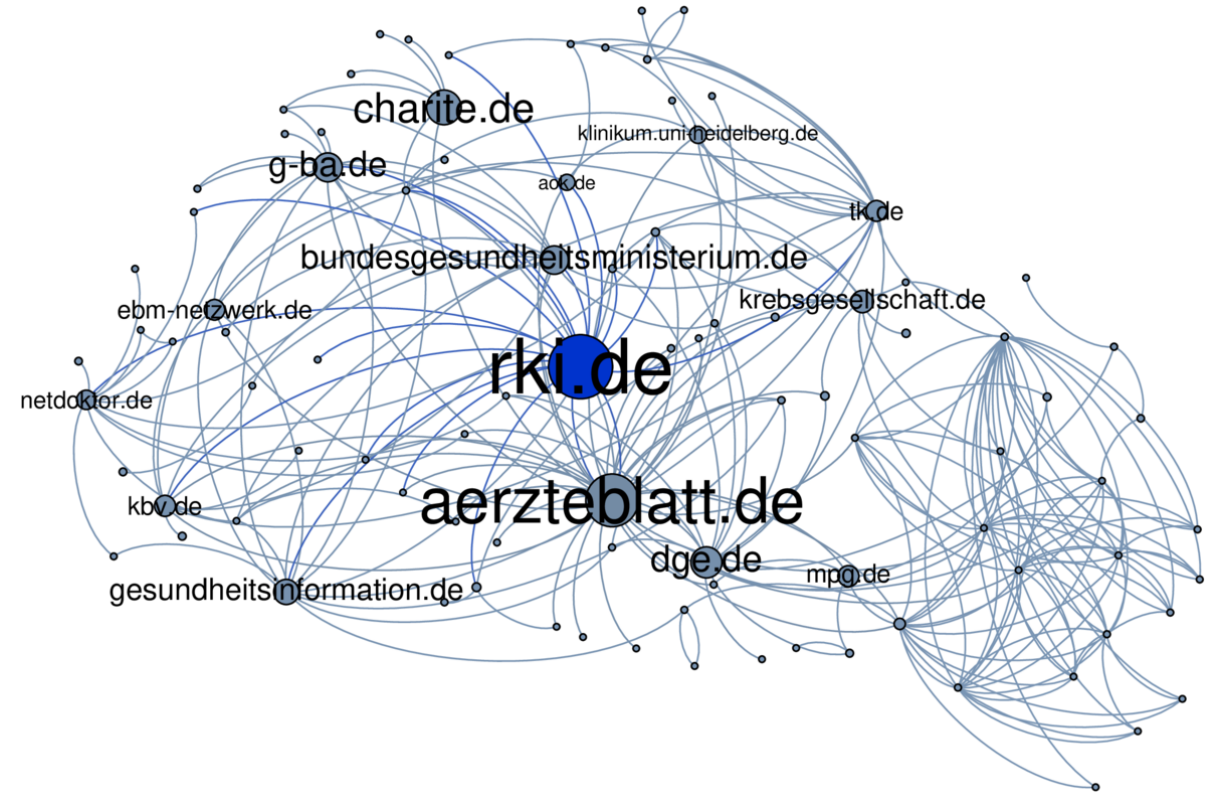
Figure 8. A small extract of the host-aggregated web graph with focus on the website www.rki.de. The surrounding nodes represent websites with a maximum link-distance of two starting from www.rki.de. An edge between two nodes implies that there exists at least one hyperlink between some web pages of the hosting websites in either way. Only those websites are included whose content is highly health-related (ie, which were automatically classified as belonging to H with a probability equal to or greater than 0.93). Moreover, they have at least one ingoing and one outgoing link. The bigger a node and its caption, the higher is its page rank. For illustration reasons, directional arrows were not